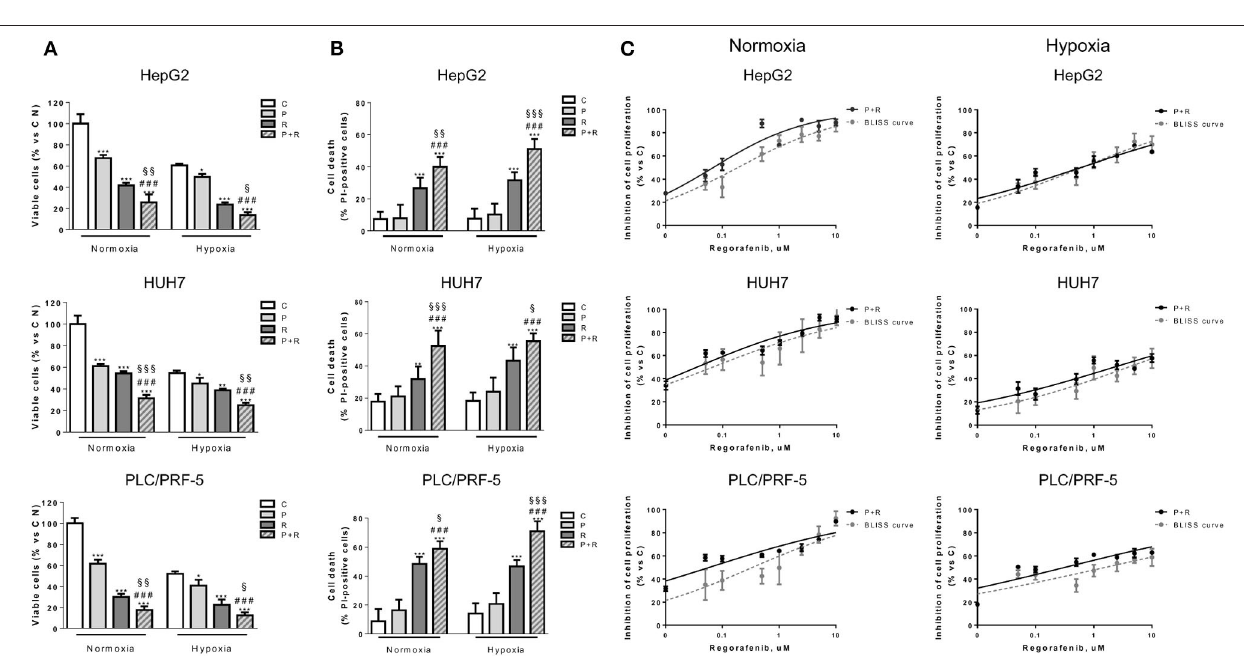
FIGURE 3 | Palbociclib combined with regorafenib inhibits cell proliferation/viability with additive effects and induces cell death under both normoxic and hypoxic conditions. HepG2, HUH7 were incubated with 0.1 µ M P, 1 or 1.5 µ M R, respectively, PLC/PRF-5 with 0.5 µ M P, 7 µ M R, alone or in simultaneous combination under normoxic or hypoxic conditions. After 72h, the cells were counted using the trypan blue dye exclusion method (A) and the percentage of cell death was evaluated after Hoechst 33342 and PI staining (B) . Data are expressed as percent vs. control cells in normoxia or as percent of dead cells, respectively. * p < 0.05, ** p < 0.01, *** p < 0.001 vs. C; ### p < 0.001 vs. P; § p < 0.05, §§ p < 0.01, §§§ p < 0.001 vs. R. (C) HepG2, HUH7 were treated with 0.1 µ M P and PLC/PRF-5 with 0.5 µ M P in combination with increasing concentrations of R (from 0.05nM to 10 µ M) under normoxic or hypoxic conditions. After 72h, cell proliferation was assessed by